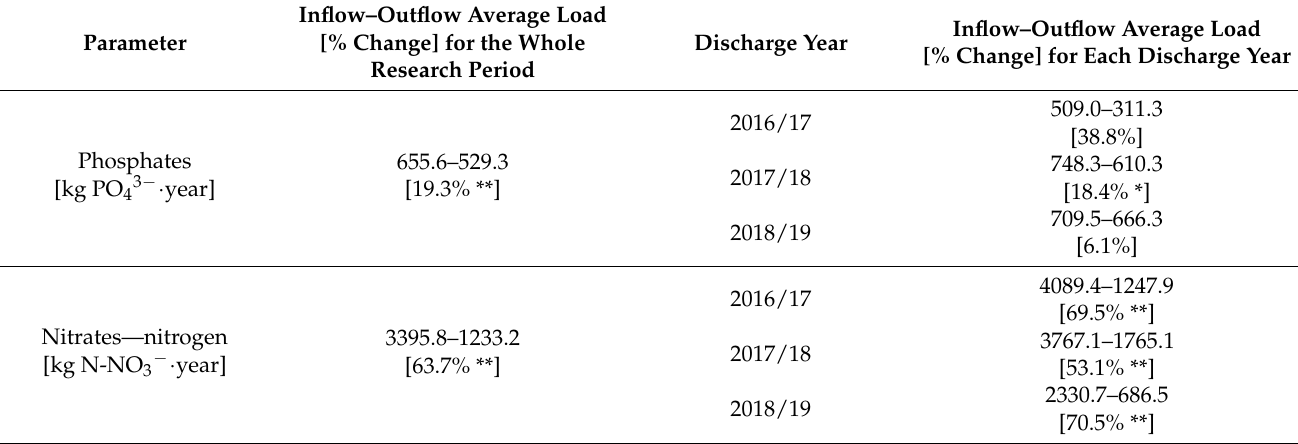
Table 3. Average loads of nutrients on the inflow to and outflow from the SED-BIO